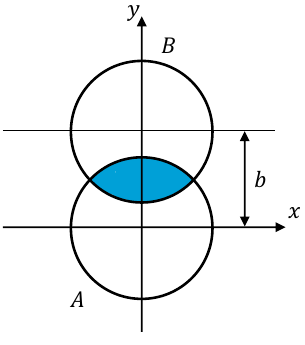
Figure 4. Overlap of the geometrical cross sections of the two nuclei. The z axis points into the page. ¯ n ( b ) can be determined from this